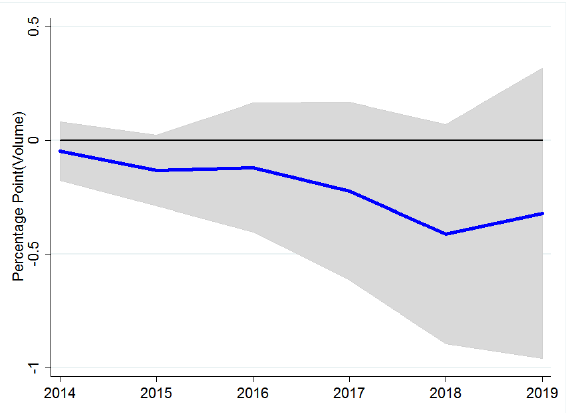
Figure 6. Cumulative Response of Volume to Dummy2014.